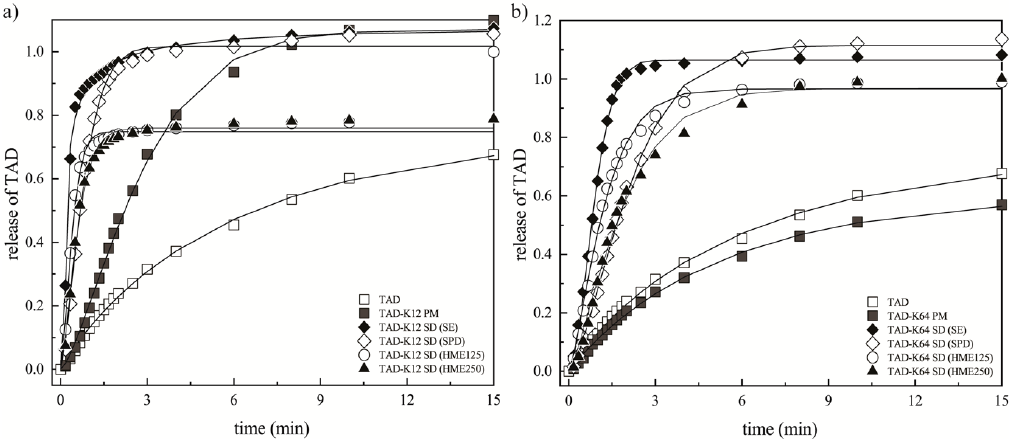
Figure 13. Dissolution profiles of TAD formulations (points) fitted by Weibull model (lines): ( a ) K12 groups and ( b ) K64 groups. Table 3. Kinetic parameters of TAD release (K12 polymer matrix).